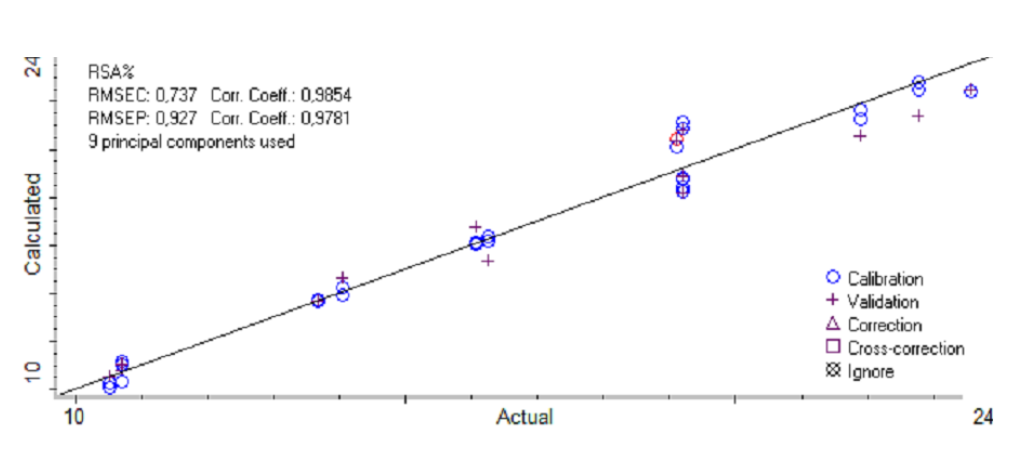
Figure 4. PLS calibration model for correlation between actual and predicted value of radical scavenging activities of fish oil samples. The x-axis showed the actual radical scavenging activity, the y-axis showed the calculated radical scavenging activity based on FTIR spectra using the optimum